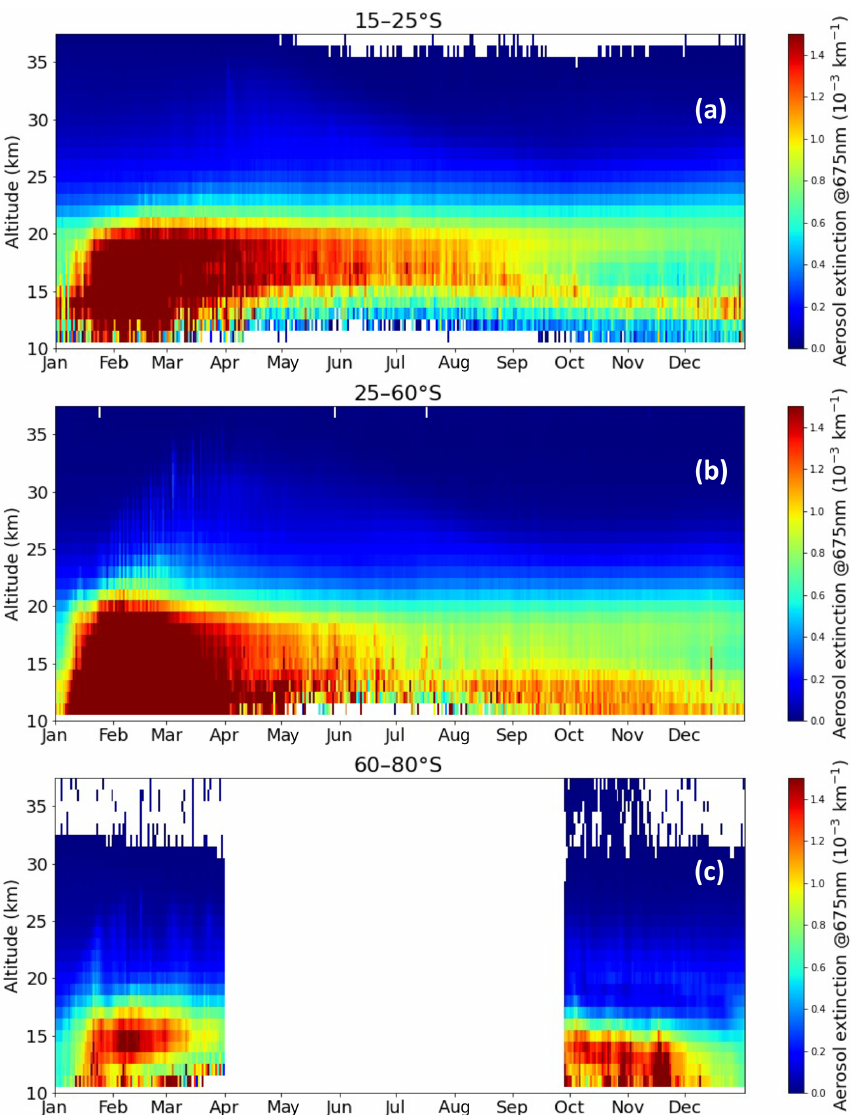
Figure 2. Time series of the vertical profiles of the aerosol extinction at 675nm from OMPS-LP observations. Time series are shown as zonal averages in the latitude interval 15–25 ◦ S (a) , 25–60 ◦ S (b) and 60–80 ◦ S (c) . The period between April and September 2020 is excluded for the band 60–80 ◦ S due to limitations in the geographical sampling of OMPS-LP and its observation